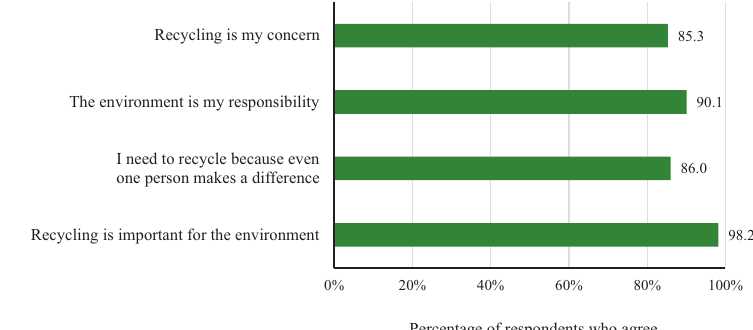
Figure 1. Percentage